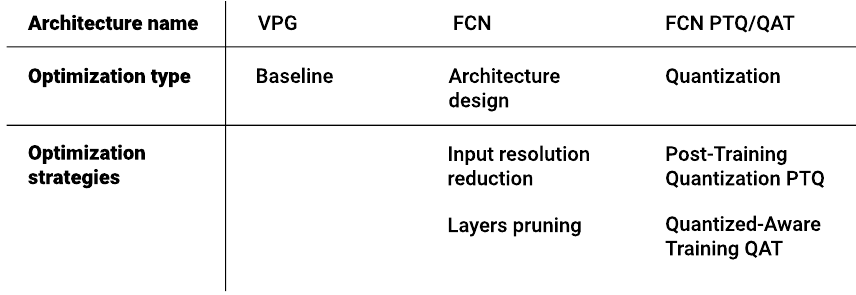
Figure 1. Overview of all the optimization strategies